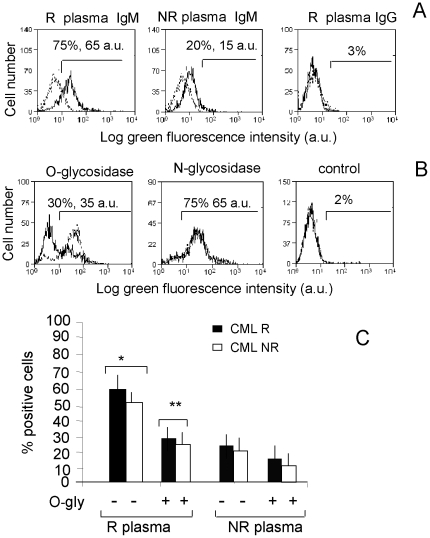
BM IgM from responder CML patients react with leukemic cells.Leukemic cells (CML) from R (panels A-C) or NR (panel C) patients were used. After incubation with BM plasma and staining with FITC anti-human IgM or IgG, samples were run on a CyAn ADP cytofluorimeter, gated on leukemic cells, after exclusion of cell debris on the basis of FSC and SSC, and results expressed as log green fluorescence intensity (a.u.) vs number of cells (A and B) or as percentage of positive cells (C). Panel A: Black lines: BM plasma samples of representative R (left and right histograms) or NR (central histograms) patients, diluted 1∶10, were incubated with R CML, followed by FITC-anti-human IgM (left and central histograms) or anti-human IgG (right histogram) antisera. Numbers in each histogram: percentage and mean fluorescence intensity (arbitrary units, a.u.) of positive cells. Grey-dotted lines: CML incubated with FITC-anti-human IgM or anti-human IgG antisera alone. Panel B: CML cells from a representative R patient were untreated (grey-dotted lines) or treated (black lines) with 20 µU/mL O-glycosidase (left histogram) or 10 mU/mL N-glycosidase (central histogram) for 4 h at 37°C before incubation with autologous BM plasma followed by FITC-anti-human IgM antiserum; right histogram: CML incubated with FITC-anti-human IgM alone. Numbers in each histogram: percentage and mean fluorescence intensity (a.u.) of positive cells. Panel C: CML cells from R (black columns) or NR (white columns) patients, untreated (−) or treated (+) with O-glycosidase were incubated with BM plasma samples from R or NR patients, followed by FITC-anti-human IgM, run on a CyAn ADP as above, and results expressed as percentage of positive cells. Mean±SD from 22 R and 8 NR patients. * p<0.001 vs NR; **p<0.001 vs (−).